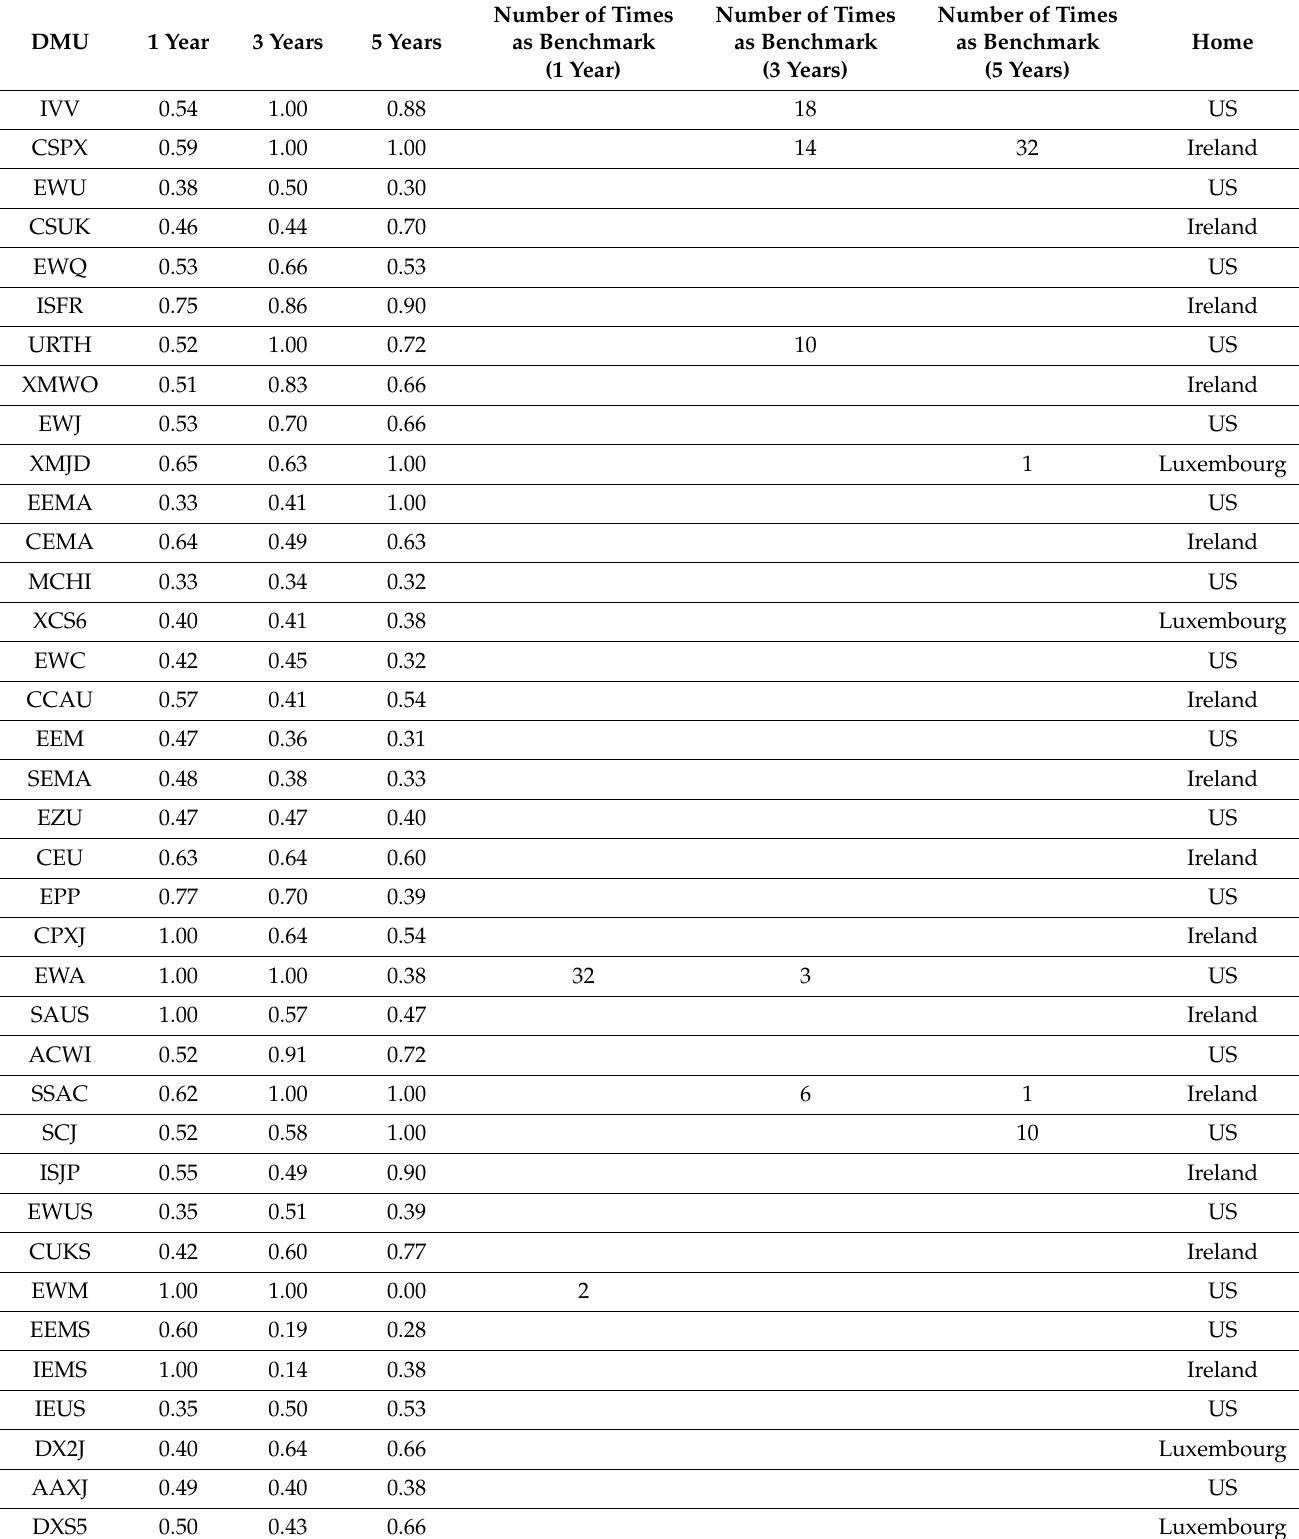
Table A9. Efficiency scores and benchmarks computed with model